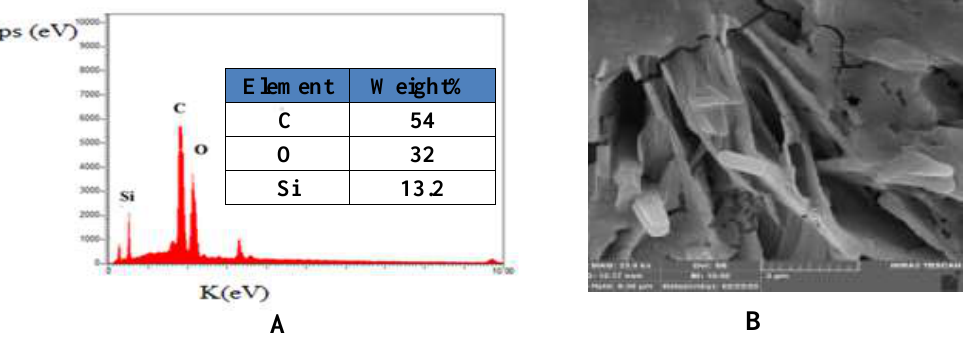
Fig.3: (A) SEM image for CNTs at laser energy 750mJand no. of pulses 100pulse and (B) EDS spectrum and weight percentage of elements in carbon nanotubes